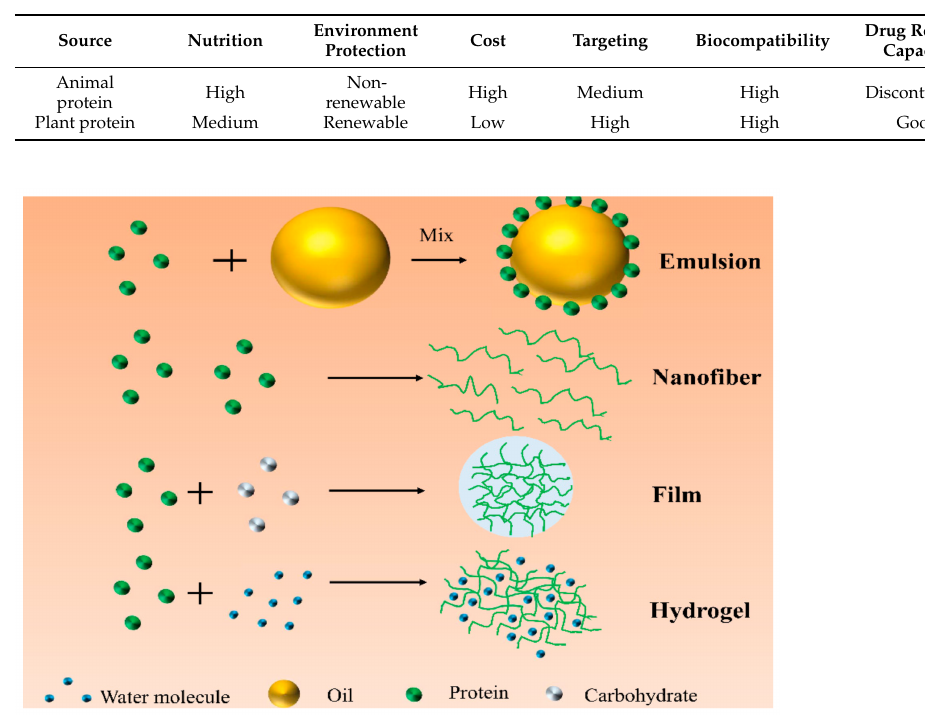
Table 1. Comparison of characteristics between animal and plant protein-based nanocarriers.